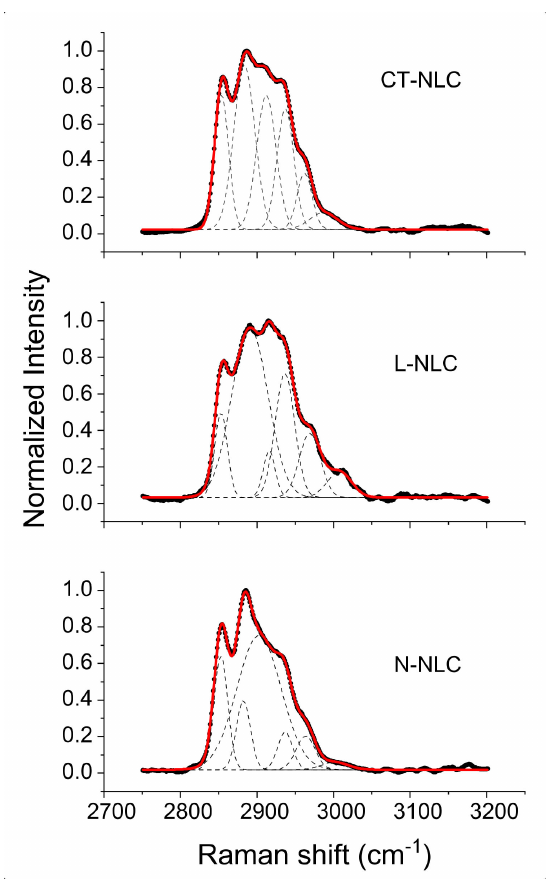
Figure 4. Raman spectra of NLC prepared with Lavandula (L-NLC), Tegosoft CT (CT-NLC), and Neem oil (N-NLC): region around 3000 cm − 1 .